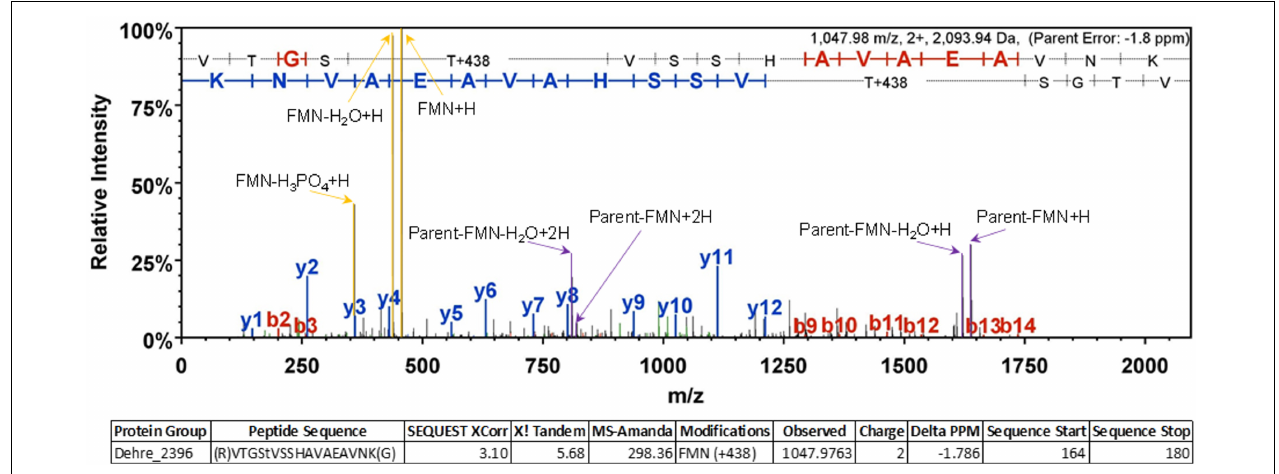
FIGURE 5 | Representative MS/MS spectrum confirming the FMN localization at position T168 of PceC. Diagnostic ions corresponding to the FMN+H and its fragments are highlighted in yellow allowing unambiguous identification of the post-translational